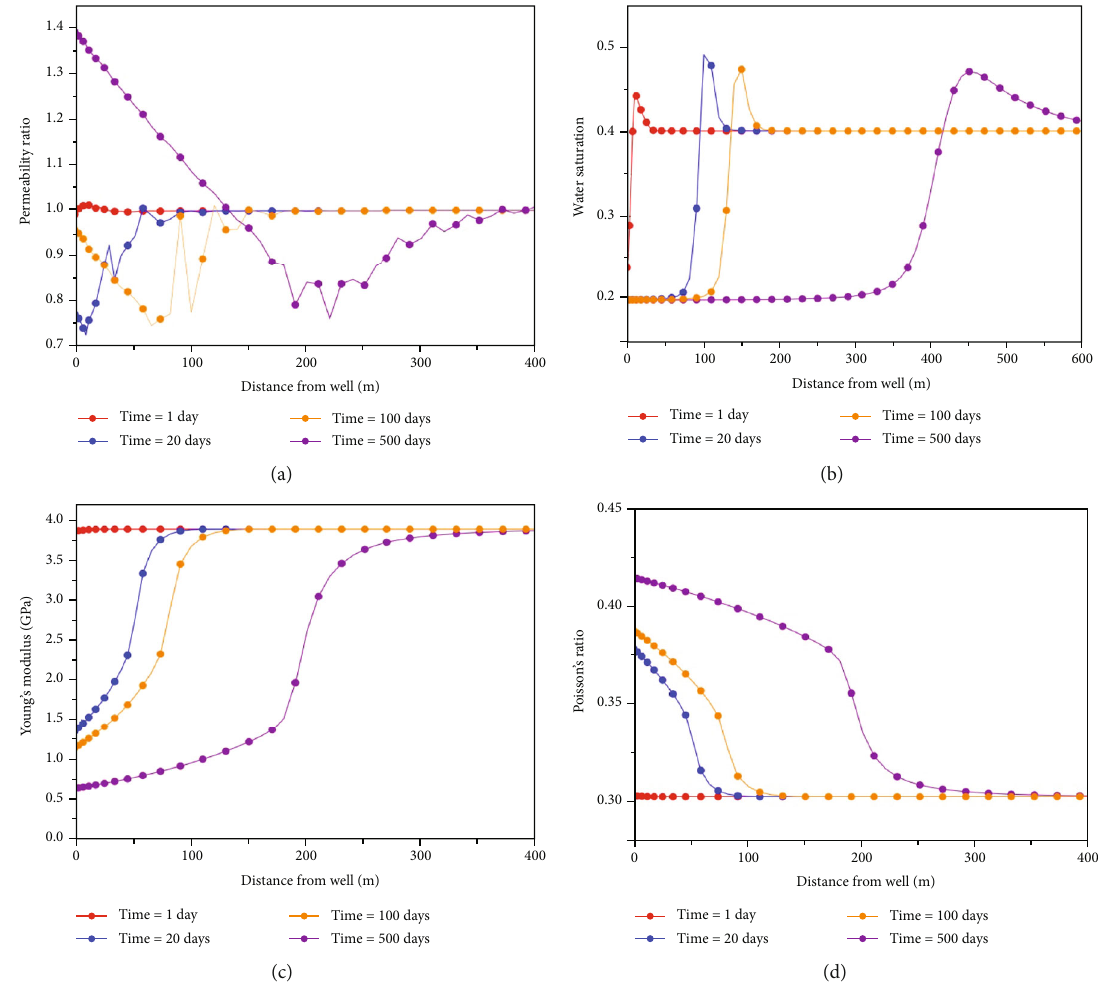
Figure 10: The spatial distribution of (a) permeability ratio, (b) water saturation, (c) Young ’ s modulus, and (d) Poisson ’ s ratio after 1 day, 20 days, 100 days, and 500 days of